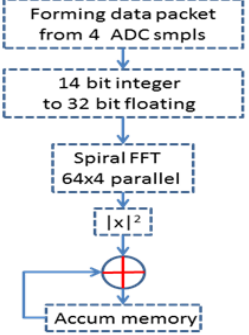
Fig.3. Spectra accumulating conveyer block, which implements equation (1) in real time.